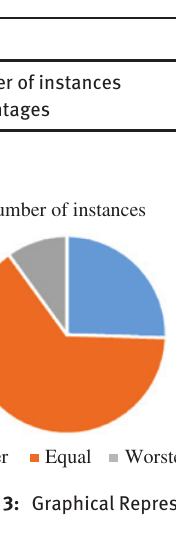
Table 2: Summary Results.